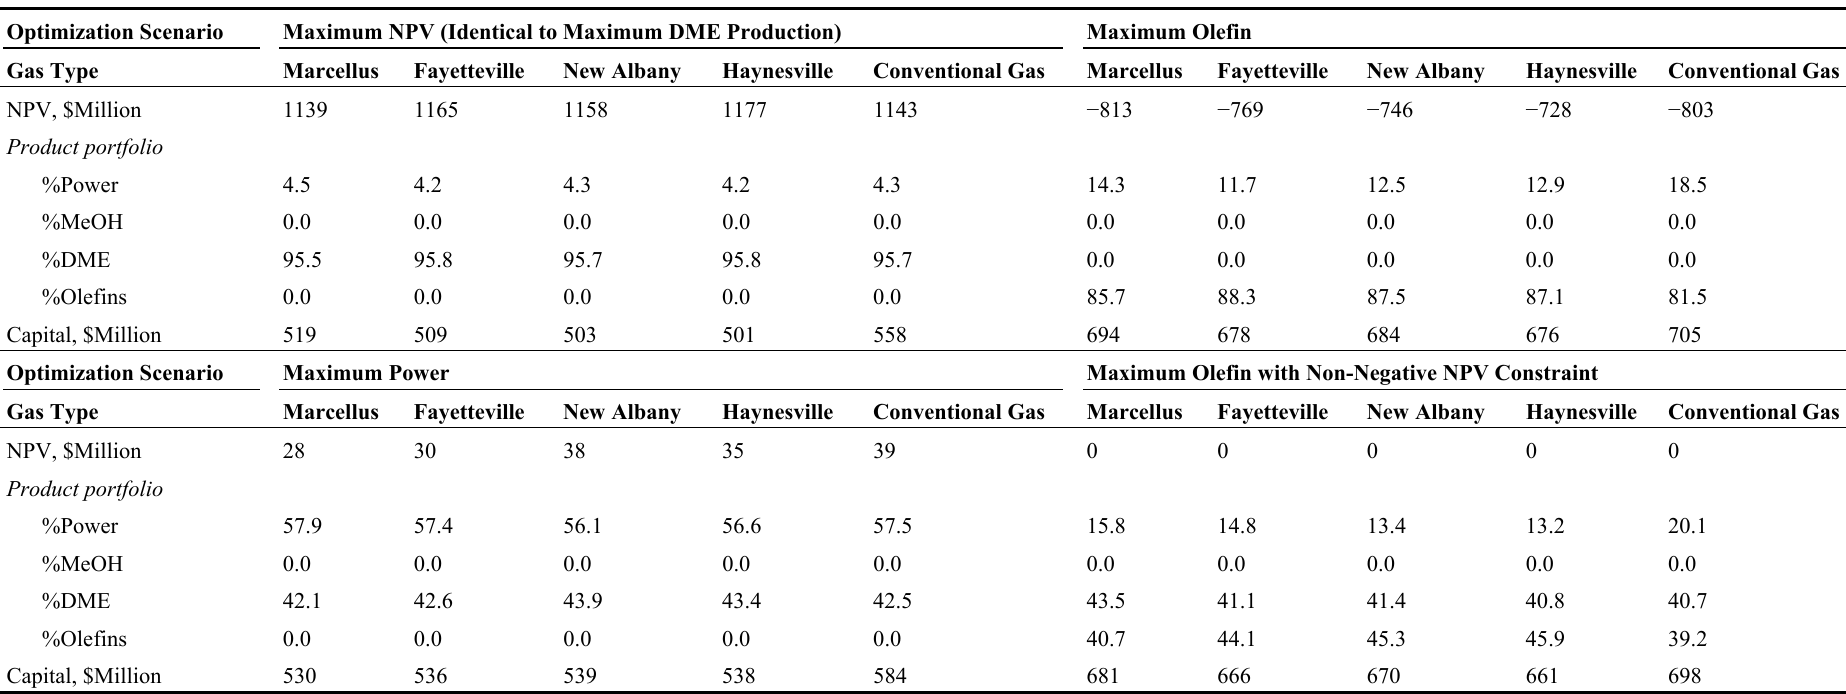
Table 4. Comparison of optimization results different shale gases at the same energy input (1111 MW) and with NiO-CLC power generation